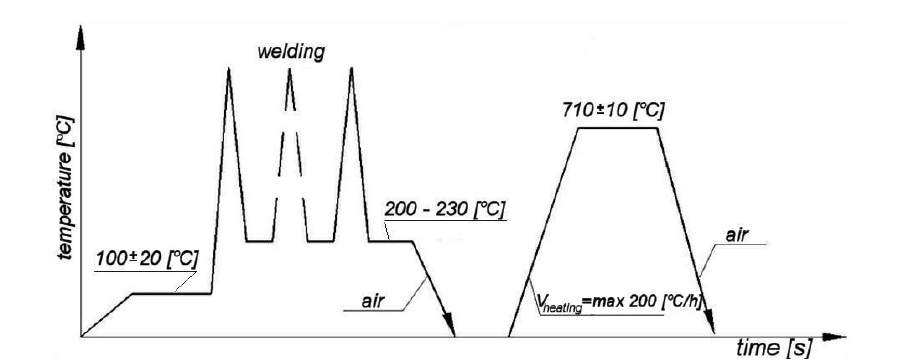
Figure 5. Diagram of heat treatment procedures used for welding G17CrMo5-5 cast steel. Table 3. Technological parameters of test joints fabrication.